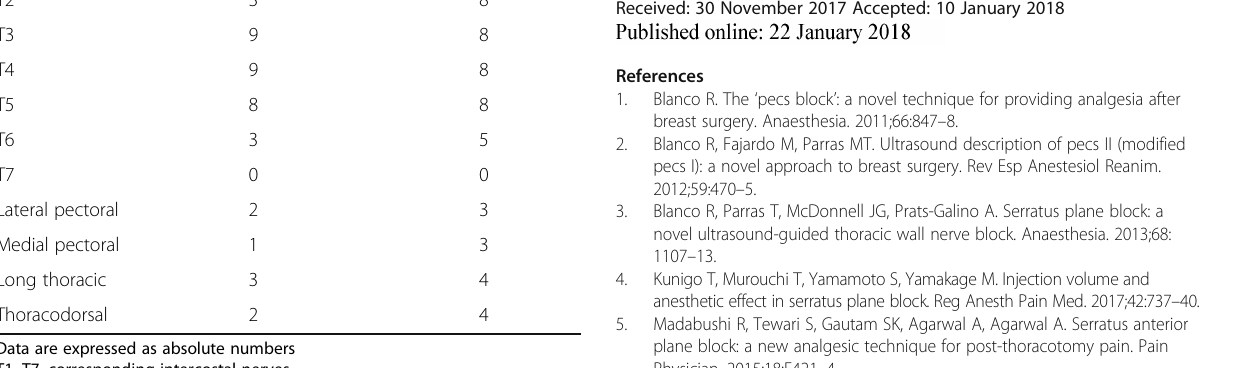
Table 1 The number of nerves stained by dye Affected nerve 20 ml ( n = 9)